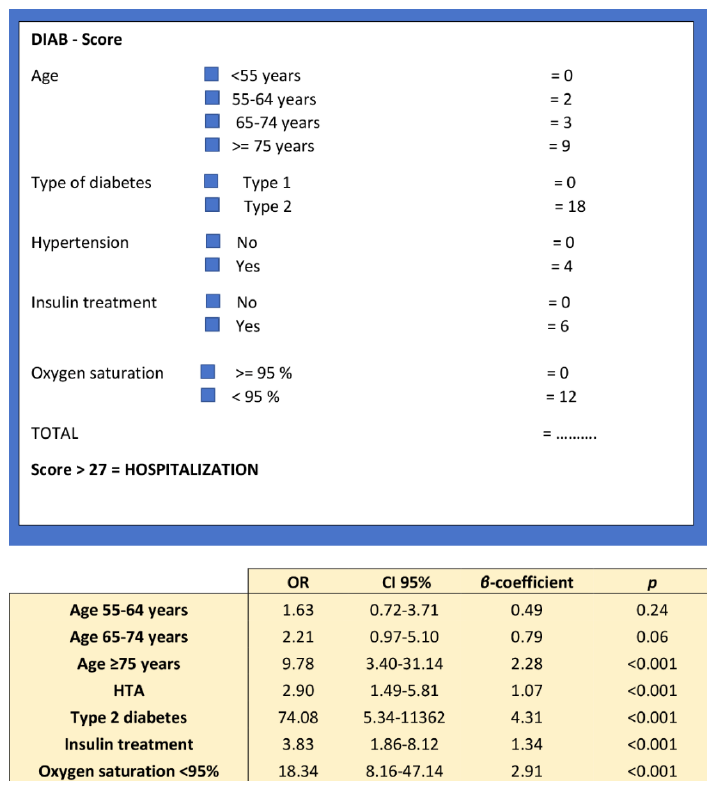
Figure 2. Diabscore: an easy-to-use hospitalization risk score.